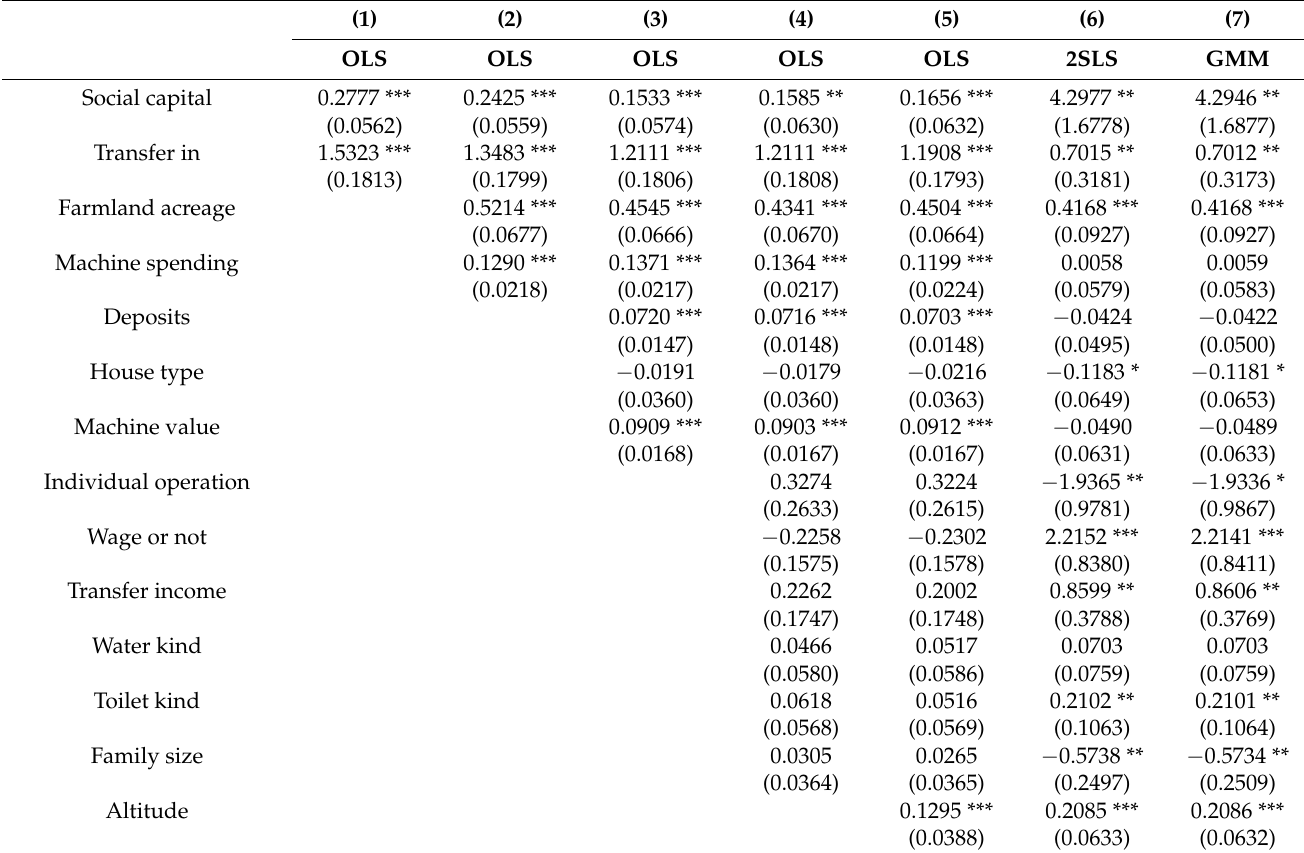
Table 2. Linear regression model results of the influence of social capital on agricultural